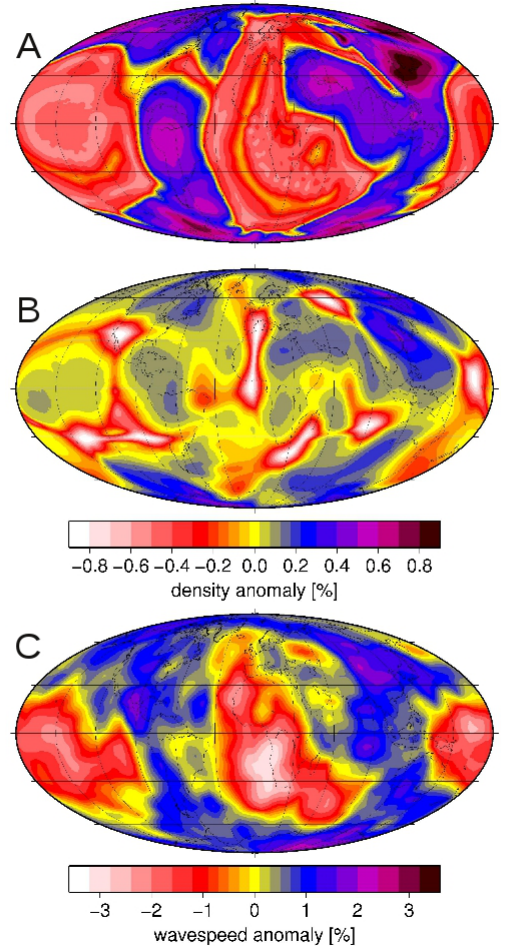
Fig. 7. Map views of predicted thermal density anomalies and seis- mic wavespeed anomalies in the lowermost 100km of the mantle. Top panel (A) : Density anomalies in the model st12den-2 with a thermochemical layer at the base of the mantle, described in Sect. 2 and shown in Figs. 5 and 6. Center panel (B) : Same for a model without thermochemical layer. No phase boundary is considered, and slabs are inserted at depths 600 and 650km 12Myr after sub- duction. However, the latter two differences only change results in a minor way; the main difference is due to presence or absence of a thermochemical layer. Bottom panel (C) : Composite tomography SMEAN (Becker and Boschi, 2002). Again, mean values are set to zero in all